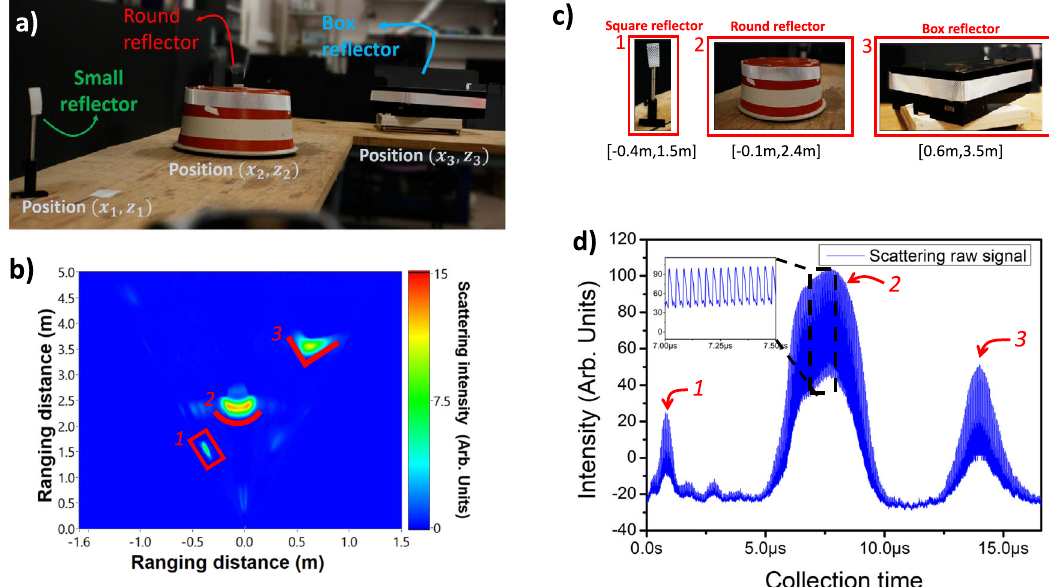
Fig.2|1Dtime-of- fl ightimaging.a Photographyofthescene. b Rangingimageof three objects displaced on a table using high re fl ective tapes to improve the intensity of the returned signal. In (1) a post with a small re fl ector wasused in (2) a roundobjectwithare fl ectorandin(3)thereisaboxre fl ectorwithatapearoundit. Thegraphshowstheimageinthecorrectrangingdistance X (scanningdimension)